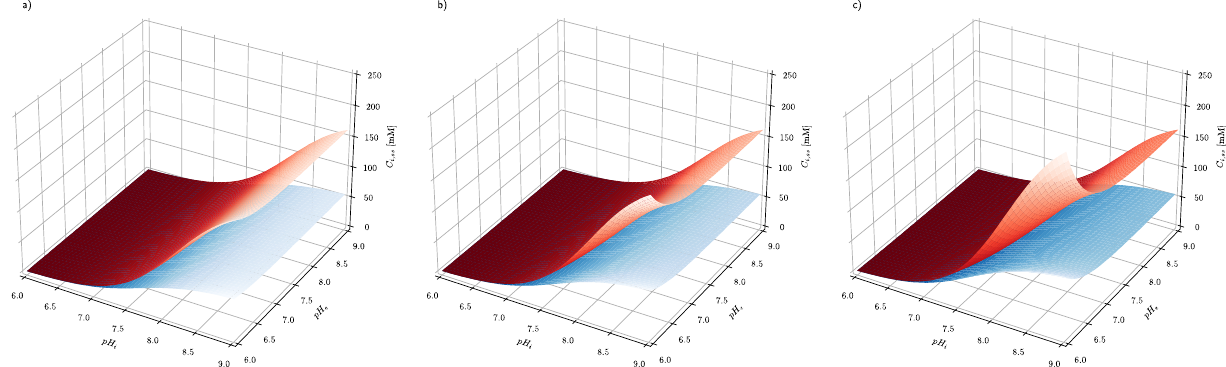
Figure 3. The effect of extracellular and intracellular pH on the intracellular steady-state ascorbate concentration. Calculations have been performed for system, where extracellular ascorbate concentration ( a ) C e = 0.2 mM ( b ) C e = 0.5 mM ( c ) C e = 1 mM and membrane electrical potential equals ∆ φ = − 10 mV and ∆ φ = − 100 mV for cancer (red surface) and healthy cells (blue surface), respectively.